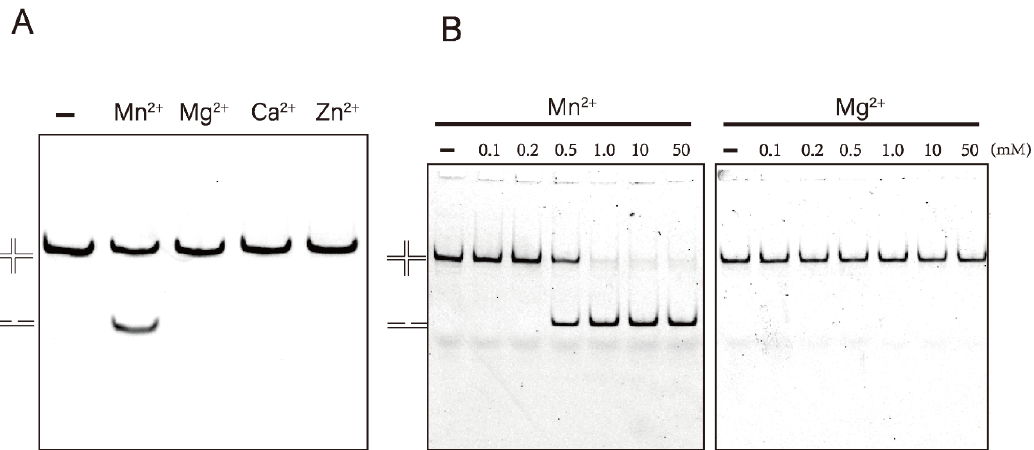
Figure 2. Effect of metal ions on the resolvase activity of DrRuvC. ( A ) The Holliday junction cleavage assays were performed in the absence or presence of indicated metal ions. Substrate uses HJ-12X with 12 bp homologous core. 500 μ M of each metal ion was used. ( B ) Metal ion titration experiment of Dr RuvC cleavage activity.